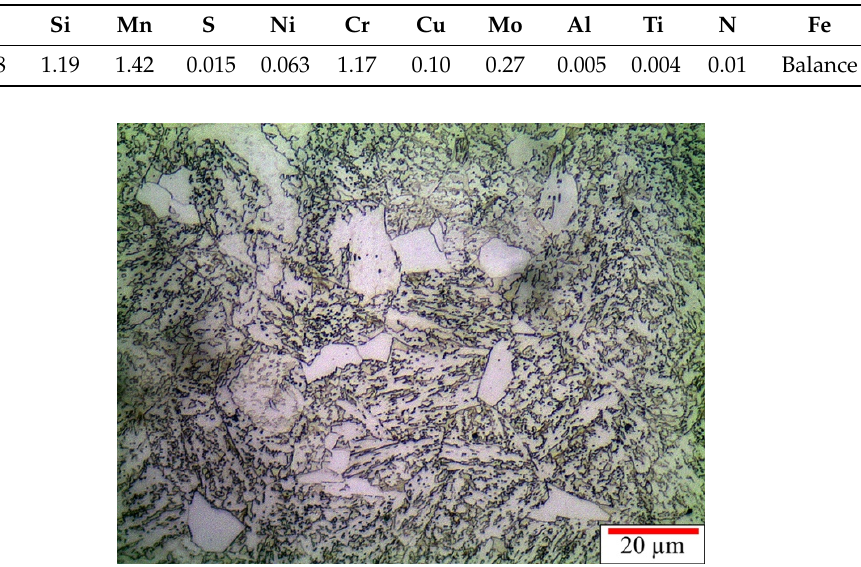
Figure 1. Optical microscopy of the DIN 18MnCrSiMo6-4 as-received microstructure.